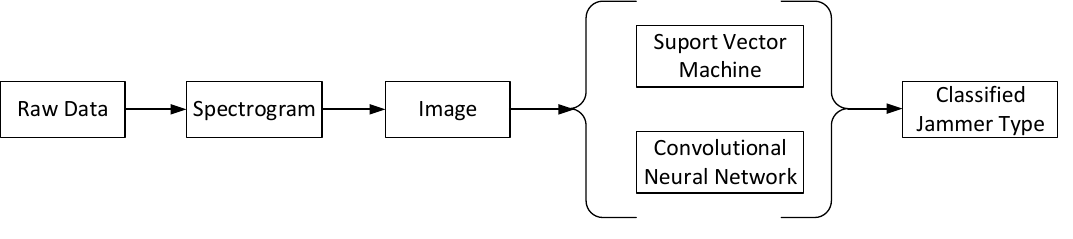
Figure 2. Block diagram of the proposed